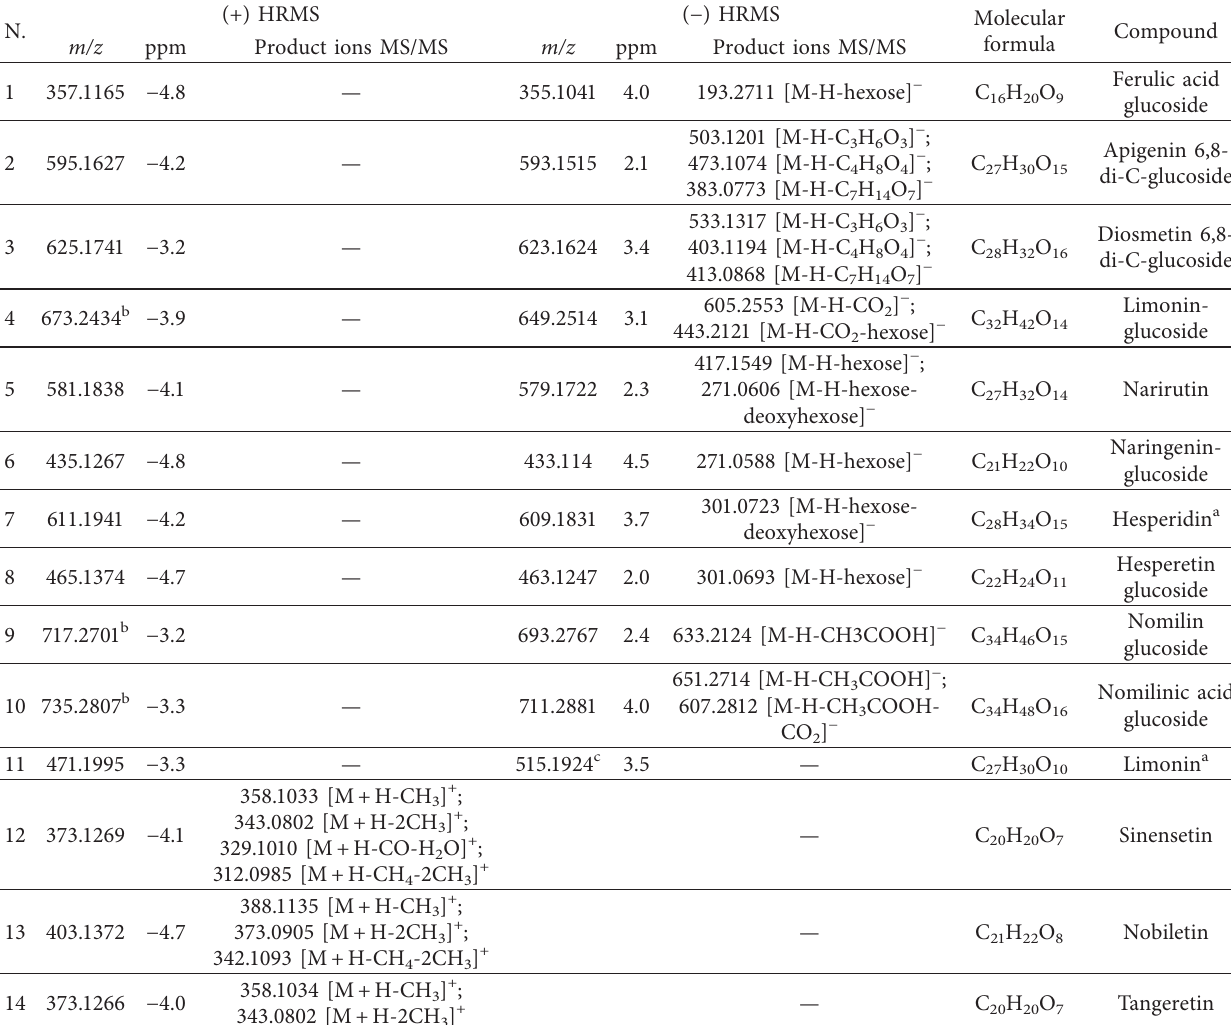
Table 2: UHPLC-HRMS/MS data of compounds detected in orange juice.